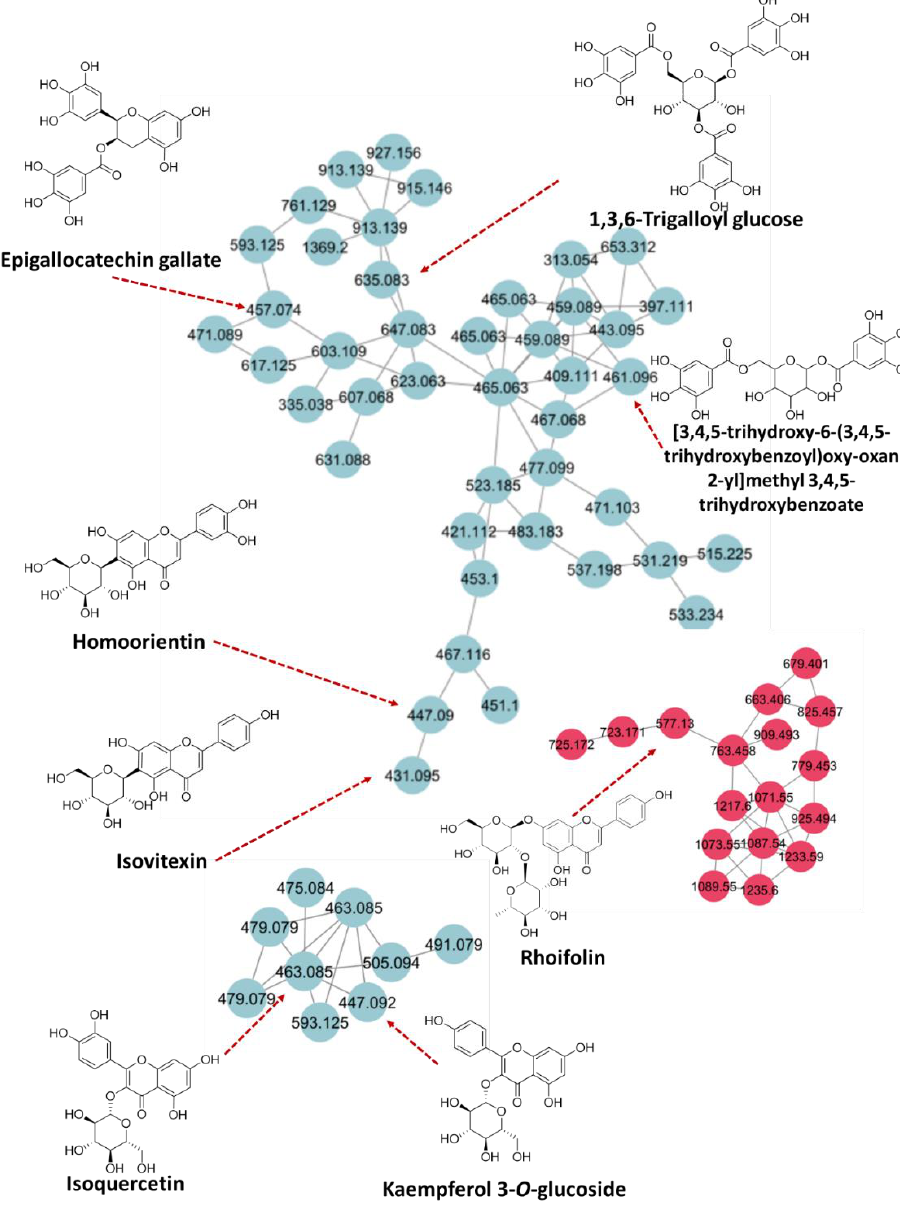
Figure 2. Chemical constituents observed in the chloroform fraction of G. velutinum leaves using LC-MS/MS and GNPS classical molecular networking.